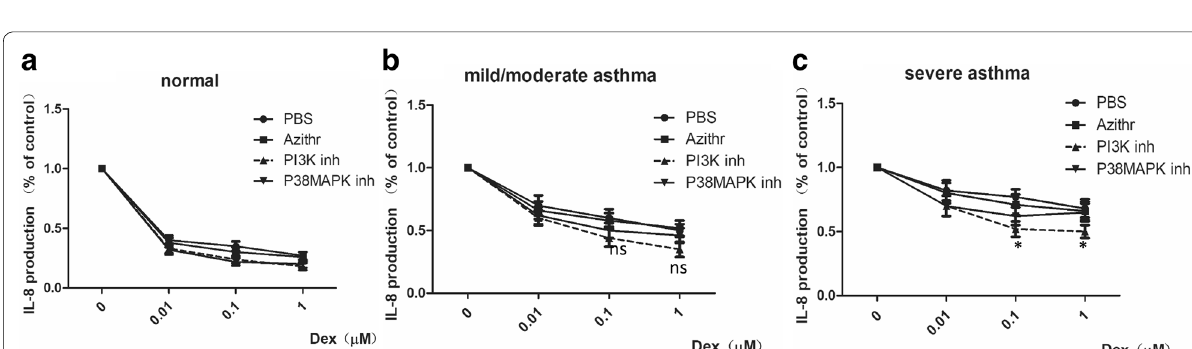
Fig. 3 Add-on compounds to reverse the dexamethasone insensitivity of PBMCs in severe asthma. a The inhibition of IL8 release in PBMCs of normal subjects when compound was added to dexamethasone (0.01 μM, 0.1 μM, and 1 μM) treated medium. b The inhibition of IL8 release in PBMCs of mild/moderate asthma when compound was added to dexamethasone (0.01 μM, 0.1 μM, and 1 μM) treated medium. c The inhibition of IL8 release in PBMCs of severe asthma when compound was added to dexamethasone (0.01 μM, 0.1 μM, and 1 μM) treated medium (IL-8 releasing level is relative to the level of group without dexamethasone treatment. *p < 0.05, PI3K inhibitor added group compared with PBS added group. ns: no significant difference, PI3K inhibitor added group compared with PBS added